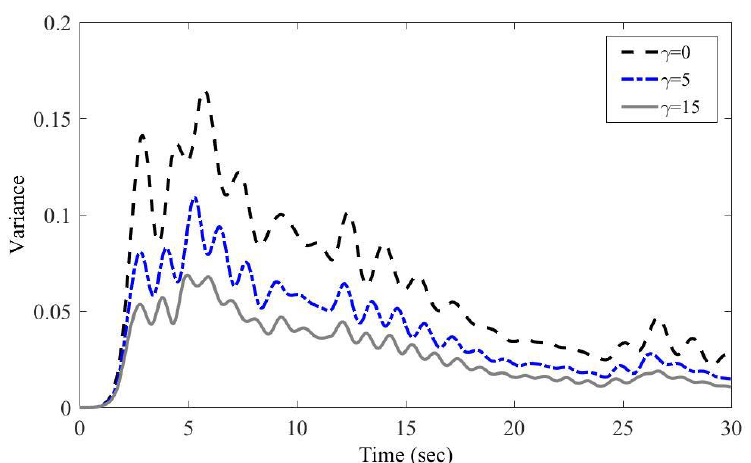
Figure 10. Mean square displacement response due to ground motion excitation ( μ = 1.0).